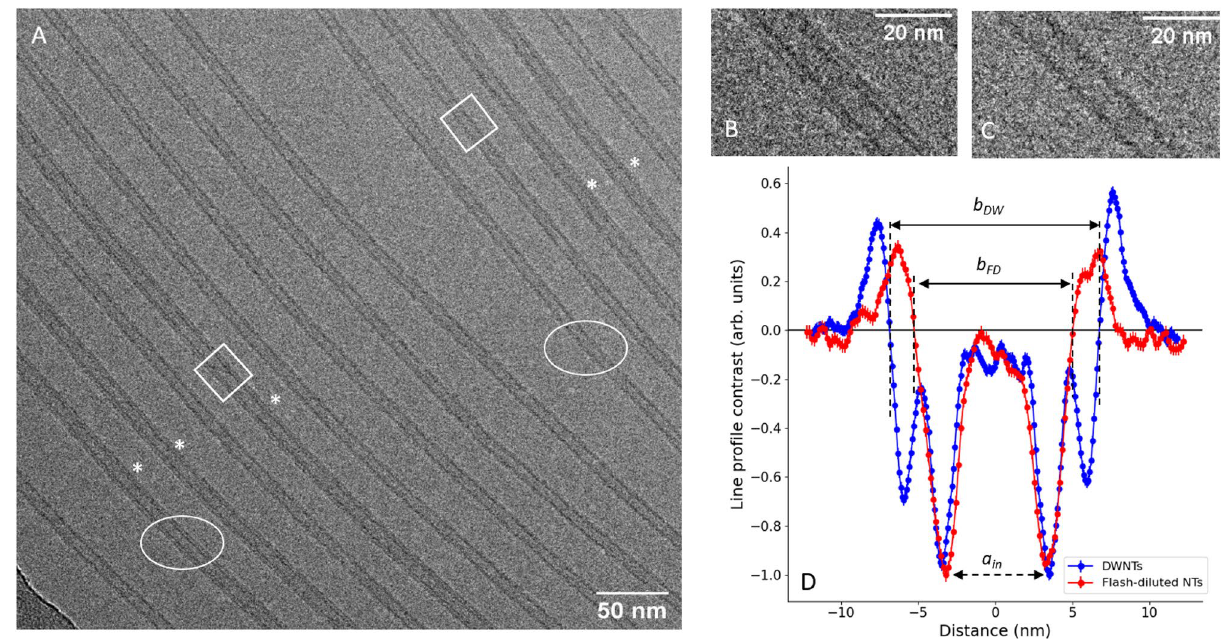
Figure 3. Cryo-TEM image ( A ) containing both DWNTs (marked by *) and flash-diluted NTs, zoomed-in (85X, shown by white oval) sections of DWNTs ( B ), flash-diluted NTs ( C ) and line profiles of DWNTs (blue) and flash-diluted (red) NTs ( D ). The cryo-TEM image ( A ) is recorded at a defocus value of ∼ 1.5 µm. The line profiles are averaged (Supplementary Information IV) over 30 TEM line profiles, each 22.5 nm in length (two examples are shown by the white rectangles). The line profiles are normalised to a minimum value of −1 for comparison after the background is subtracted (Supplementary Information IV). The solid and dashed black arrows show the two metrics used: the boundary and dip-to-dip distances, respectively, where a in is the inner dip-to-dip distance, while b dw and b FD are boundary distances of DWNTs and flash-diluted NTs,